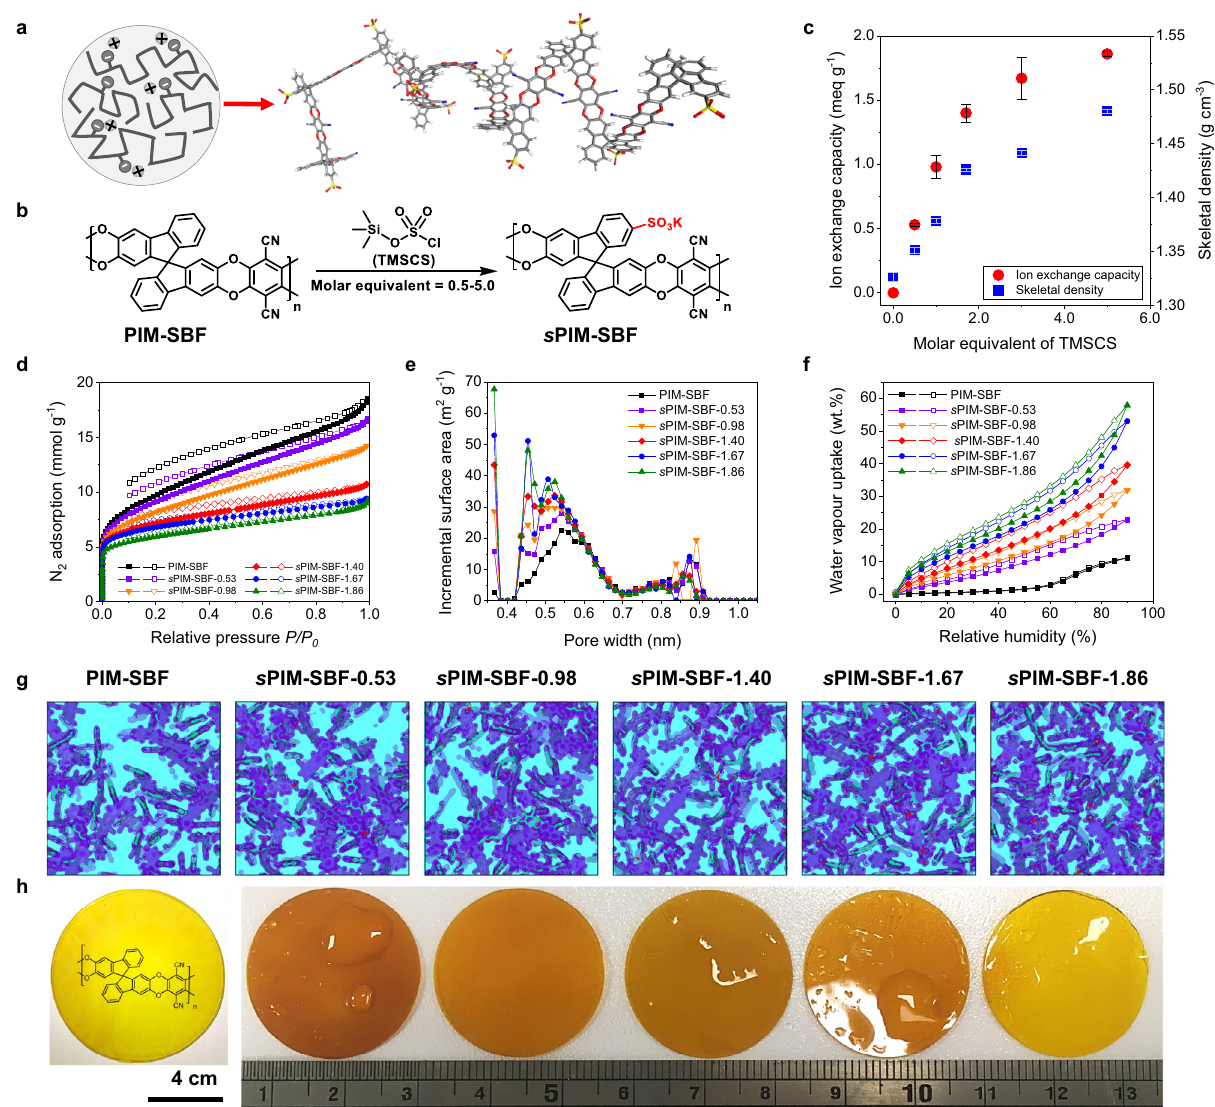
Fig. 2 Synthesis and characterization of membranes. a Schematic diagram and molecular model of a rigid and contorted PIM polymer chain with negatively charged sulfonate groups. b Synthetic route of s PIM-SBF polymers. c IEC and skeletal density of PIMs as a function of molar equivalent of TMSCS over PIM-SBF. Error bars are standard deviations derived from three IEC measurements based on three different samples, or a series of ten skeletal density measurements based on the same samples. d N 2 adsorption isotherms at 77 K. e Pore size distribution derived from CO 2 sorption based on DFT calculations. f Water vapor uptake isotherms at 298 K. g 1 nm-thick cross sections of the simulated polymer models in dry state. Purple shading highlights the isosurface of the polymer chain and light blue corresponding to the free volume. Sulfur atoms are colored in red and the polymer backbone in green. h Photograph of the PIM-SBF and s PIM-SBF membranes that corresponding to the modeling cell above each